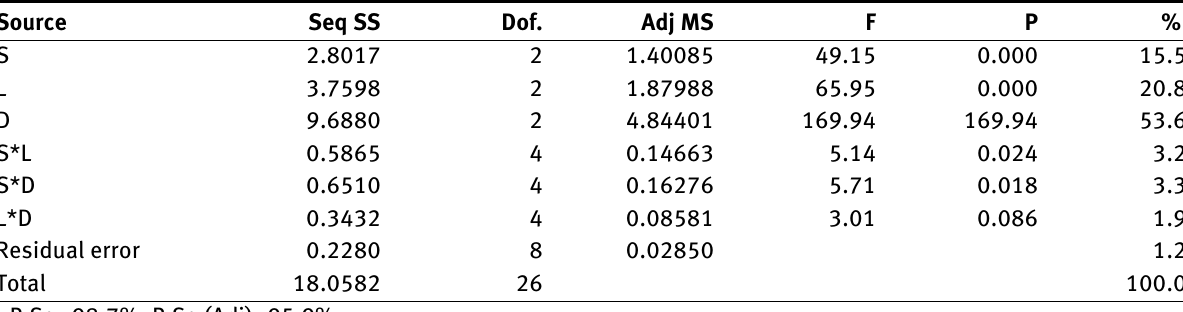
Table 6: ANOVA analysis of hybrid composite (Al2219+8% B4C + 3% Gr) Source Seq SS